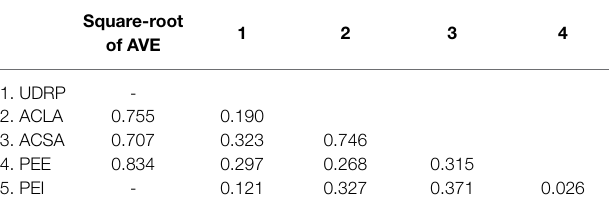
TABLE 3 | Latent variable correlations and square-root of